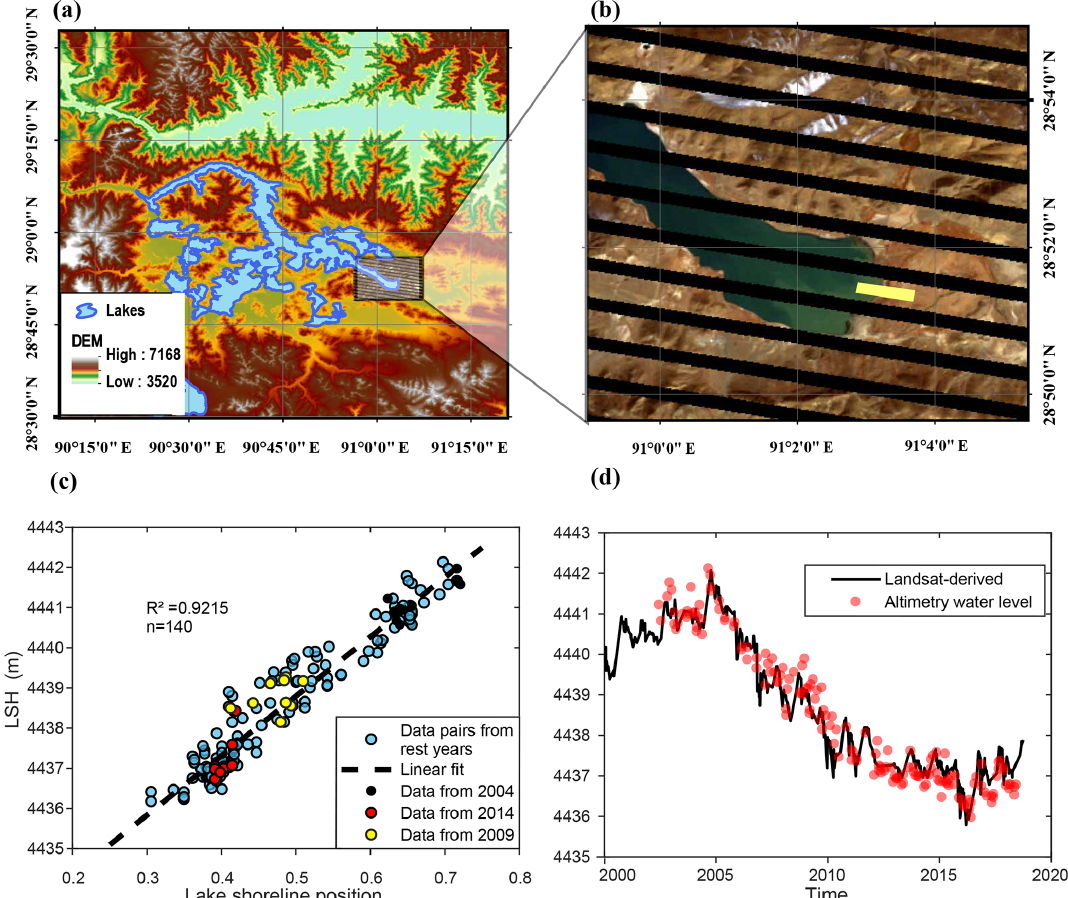
Figure 4. (a) Yamzhog Yumco and its surroundings. The DEM was extracted from the SRTM Global 90m DEM product (Jarvis et al., 2008). (b) Region of interest (ROI, yellow area) selected from a Landsat 7 ETM + image for detecting changes in lake shoreline (black areas represent gaps in the image). (c) Linear regression of lake shoreline positions that are represented by water area ratios in the ROI and altimetry water levels for Yamzhog Yumco. (d) Landsat-derived water levels and altimetry water levels for Yamzhog